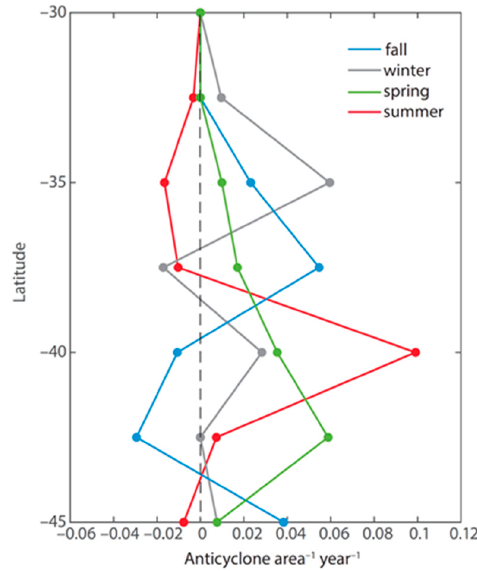
Figure 11. Difference of anticyclone density inside the box defined in Figure 1 between periods 2010–2019 and 1979–1988 at each season.